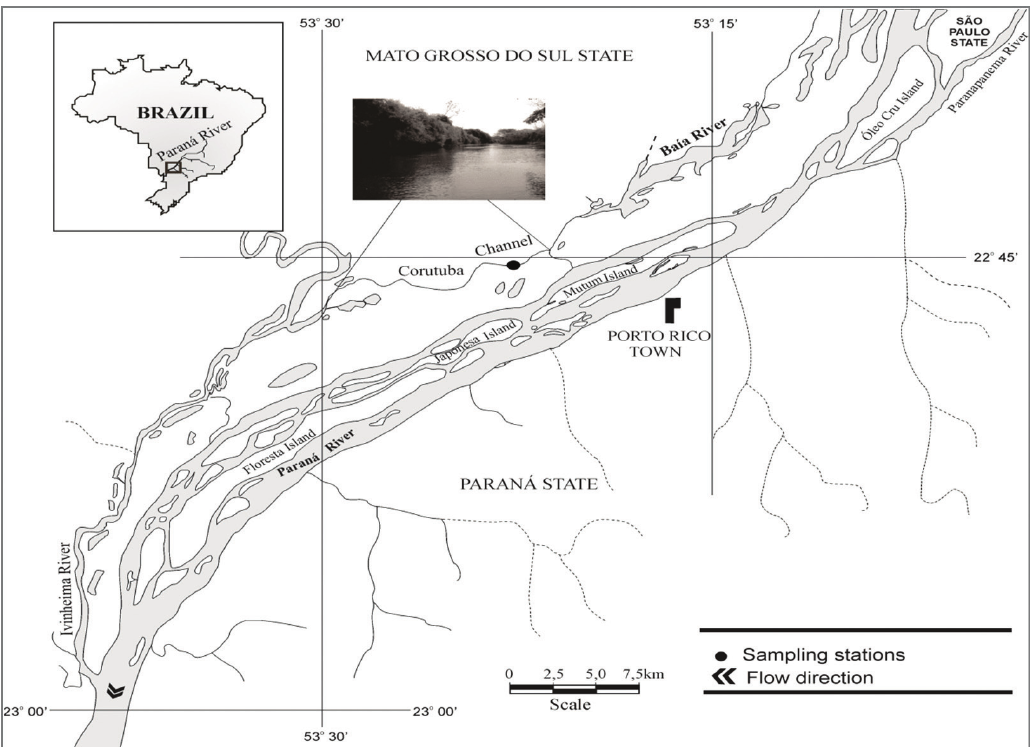
Figure 1. Map showing the location of the sampling station in the Corutuba channel, in the Upper Paraná River